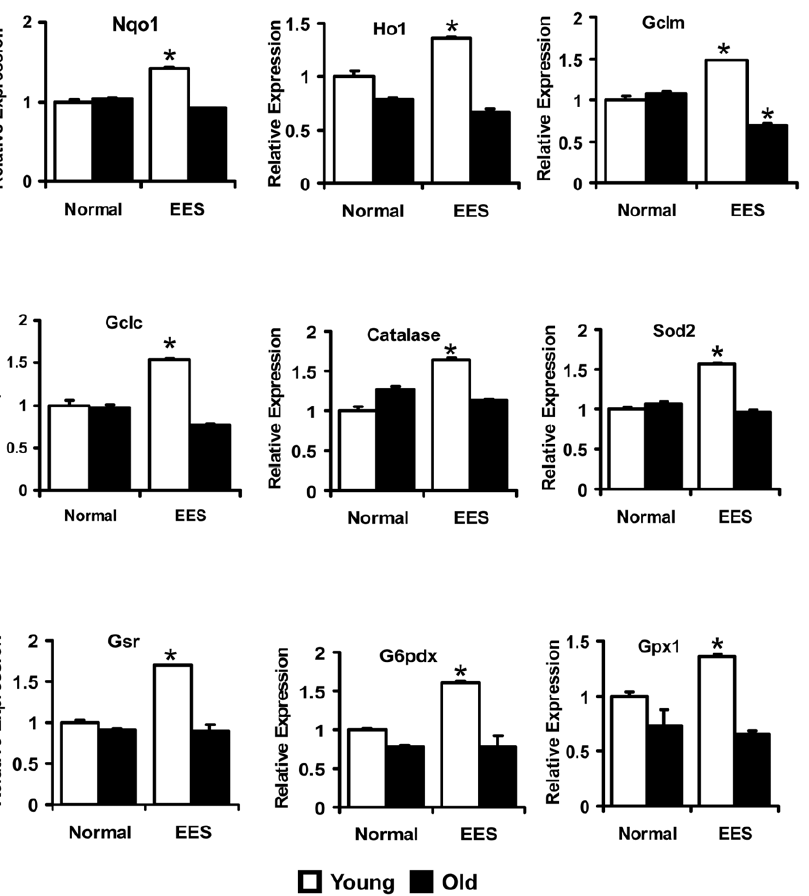
Figure 4. Transcription of Nrf2/ARE-dependent antioxidant genes in the heart. Real-time qPCR analyses for antioxidants were performed using Qiagen primer sets. Data were initially normalized to Arbp1 and then to the corresponding gene expression in the sedentary-young group. (n=4–6). *p , 0.05-between basal and EES.